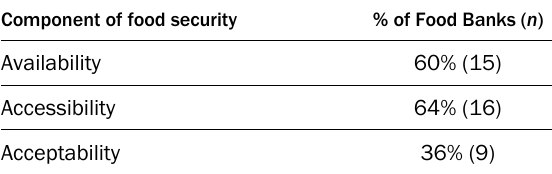
Table 4. Proportion of Seattle Food Banks that Had Any Social Media Communication on Themes Related